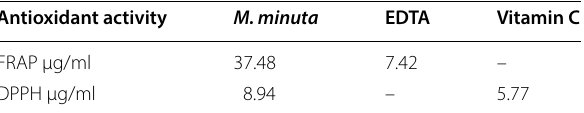
Table 2 IC50 value of FRAP and DPPH radical scavenging activity Antioxidant activity